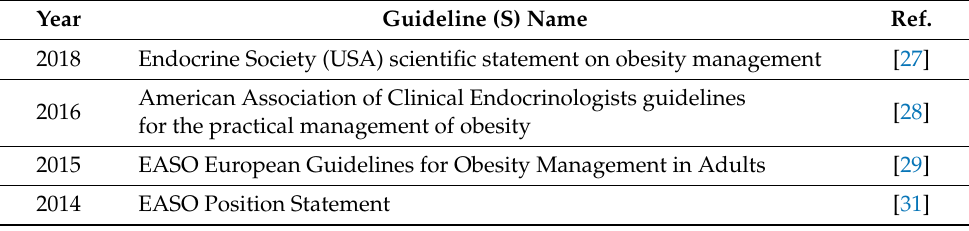
Table 2. Nutraceutical products and guidelines for